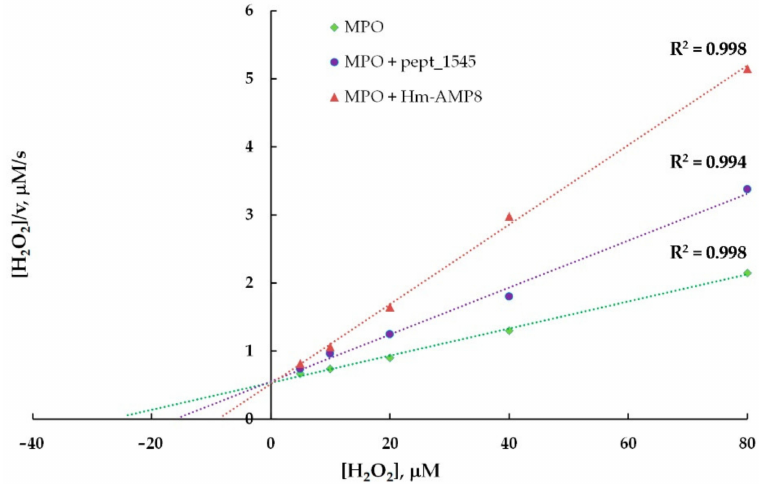
Figure 12. Hanes–Woolf plot illustrating the effects of 8 µ M pept_1545 and 0.8 µ M Hm-AMP8 on kinetics of MPO-catalyzed reaction of Cl – with H 2 O 2 ( n = 3). The concentrations were as follows: 0.8 nM MPO heme, 200 µ M CB, 150 mM NaCl, and 5–80 µ M H 2 O 2 in 50 mM Na-acetate buffer, pH